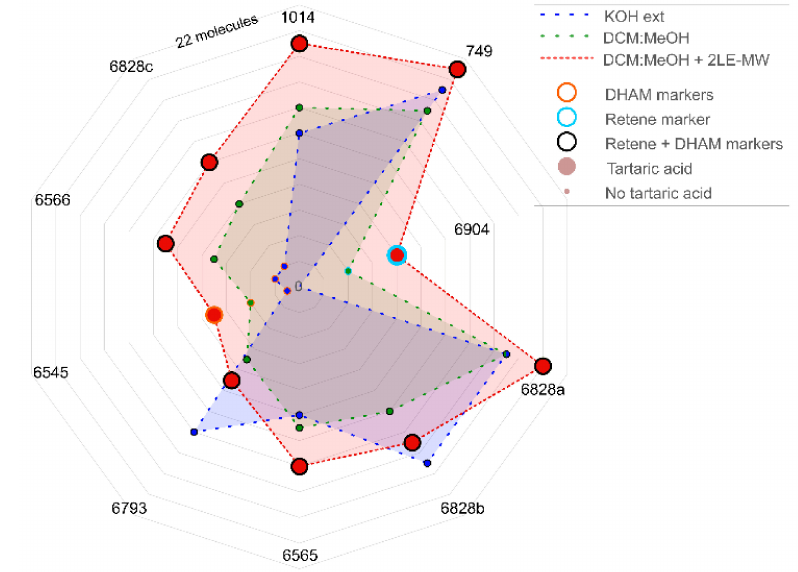
Figure 1. Radar plot of the shards.